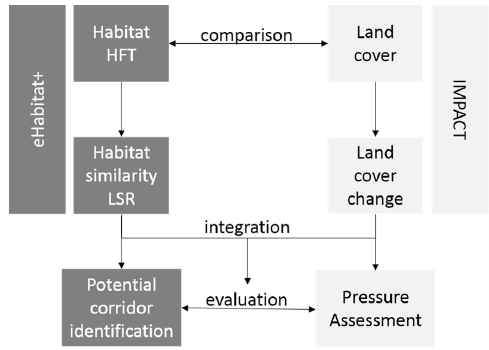
Figure 2. Processing steps including Habitat Functional Types (HFT), Landscape Similarity Maps and Ratios (LSR), land use/land cover (LULC) and land use/cover change (LULCC) assessment. The two processing environments (eHabitat+ and IMPACT) are highlighted in dark and light grey respectively.